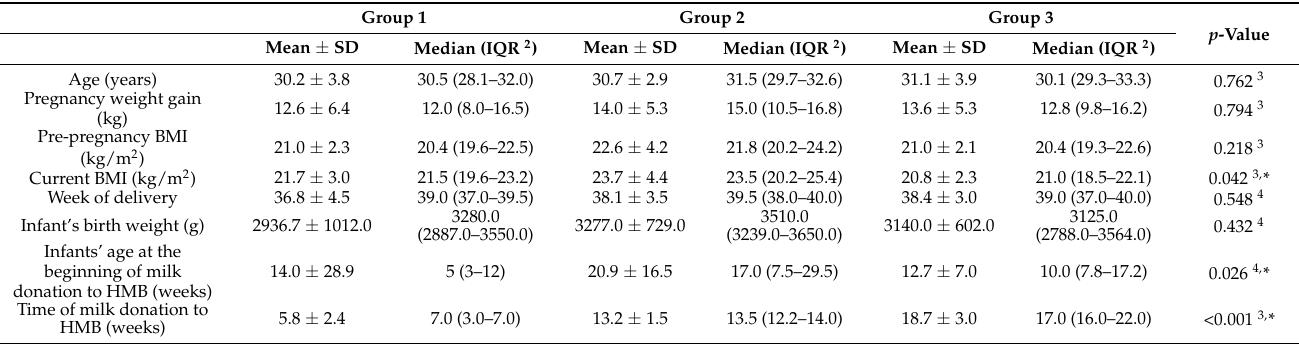
Table 6. Comparison between groups 1 selected based on terciles of the duration of milk donation to HMB. Group 1 Group